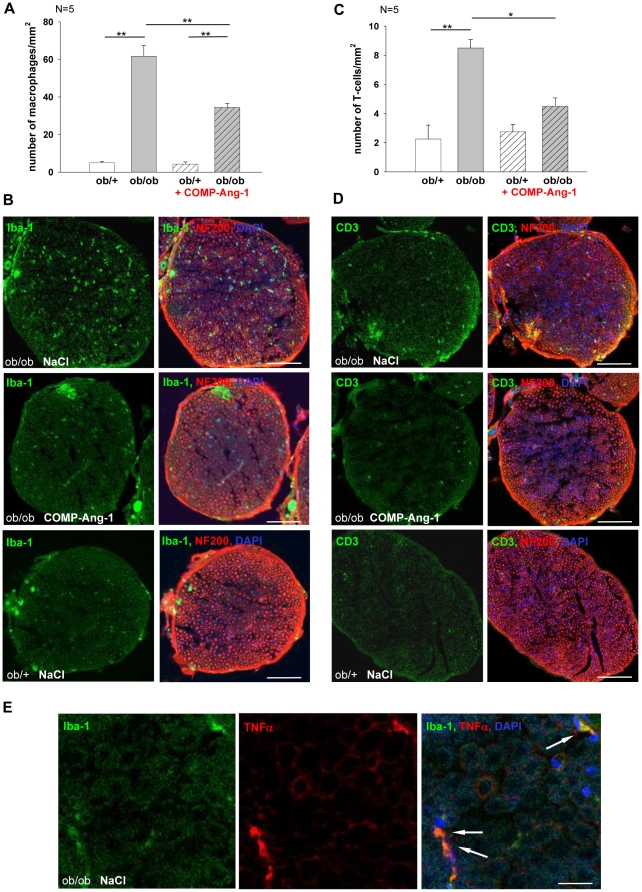
Analysis of macrophages and T cells distribution in cross sections of sciatic nerves from ob/ob and ob/+ mice under treatment of COMP-Ang-1 at 21 days.Quantification of Iba-1+ macrophages (A) and CD3+ T-cells (C) activation in sciatic nerves (n = 5). B, D: Double immunofluorescence staining against Iba1 (green, macrophages) or CD3 (green, T cells) and neurofilament 200 (red). Immunoreactivity (arrows) for macrophages and T-cells was higher in nerves of non-treated ob/ob mice compared to COMP-Ang-1 treated ob/ob or ob/+ mice. E: Double immunofluorescence staining against Iba1 (green, macrophages) and TNFα (red). Note that TNFα immunoreactivity co-localizes with macrophages (arrows). Cell nuclei were stained with DAPI (blue). Bar represents 100 µm (B, D) and 30 µm (E) respectively. Results are presented as mean ±SEM. * p≤0.05, ** p≤0.01, *** p≤0.001, according to the one-way analysis of variance together with the Newman-Keuls test.